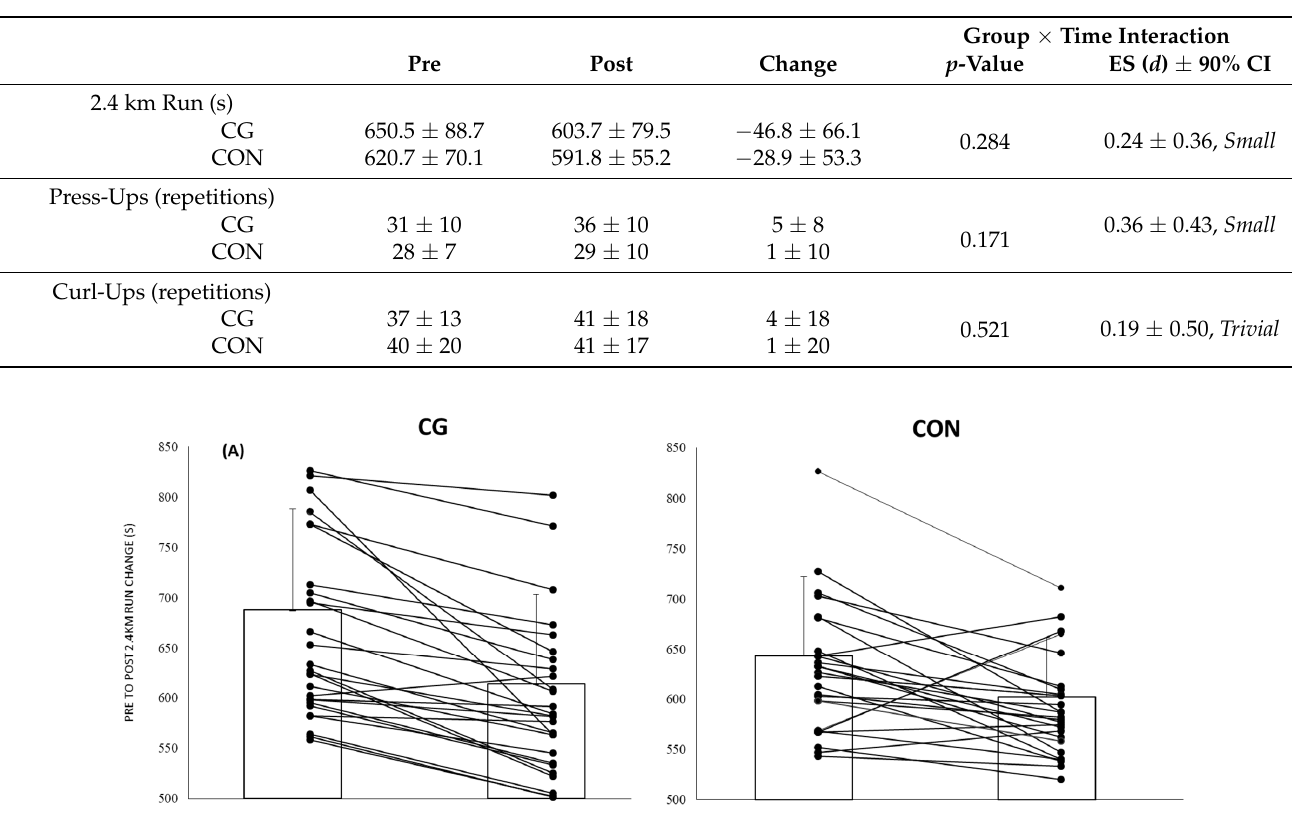
Table 3. Mean ± SD comparison for pre to post 2.4 km run, press-ups, and curl-ups, for the compres- sion garment (CG, n =27) and control (CON, n = 28) groups, including group interaction p -value, d -value, and effect size descriptor (in italics) for the duration of 6 weeks of military training.